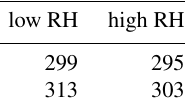
Table 2. Glass transition temperatures calculated using Eqs. (1) and (2) for toluene SOA produced at low relative humidity ( < 2%) and high relative humidity (75%) conditions.